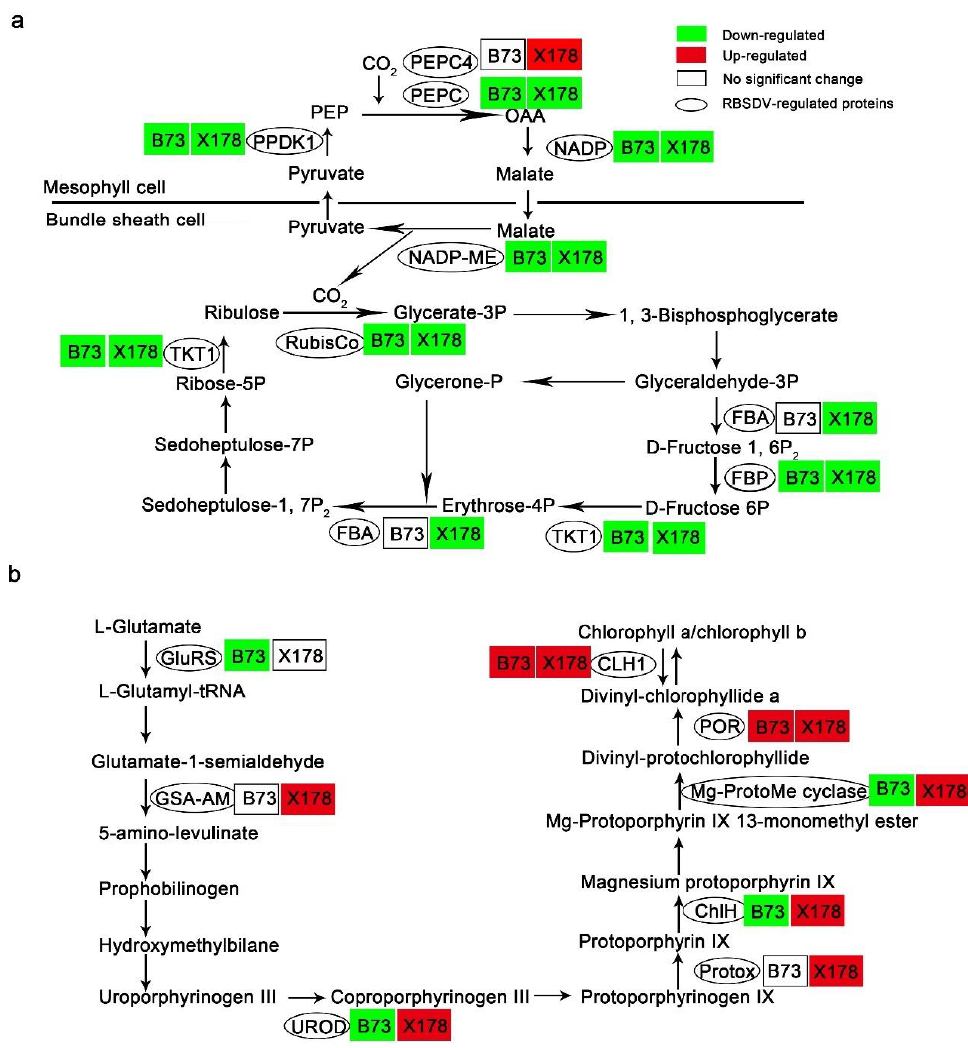
Figure 6. RBSDV infection altered proteins in photosynthesis and biosynthesis of chlorophyll a and b in leaves of maize lines B73 and X178. ( a ) RBSDV infection impeded the Calvin–Benson cycle and the C4-dicarboxylic acid cycle in both B73 and X178. PEPC, phosphoenolpyruvate carboxylase; PPDK1, pyruvate orthophosphate dikinase 1; NADP, malate dehydrogenase; NADP-ME, NADP-